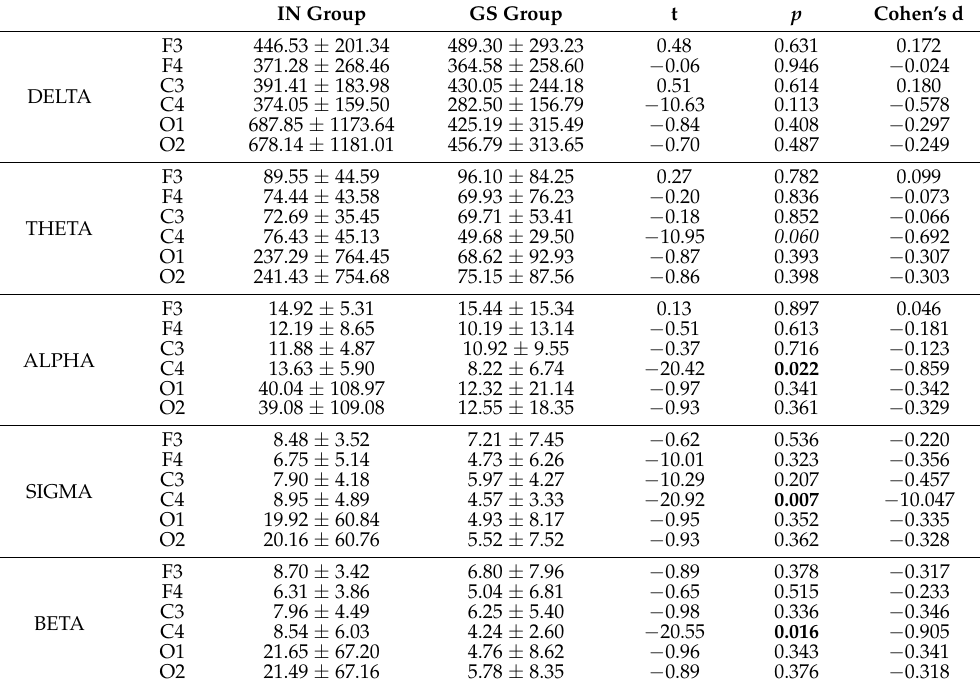
Table 5. Spectral power in the delta, theta, alpha, sigma and beta bands in the IN and GS groups. IN Group